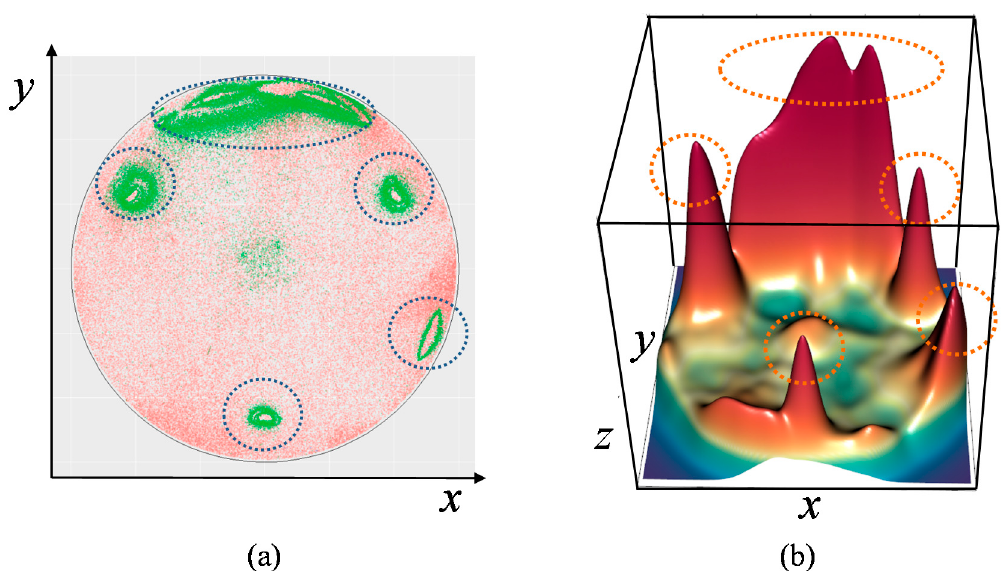
Figure 8. The conventional and new particle maps: ( a ) particle map; ( b ) kernel-density-based particle map.